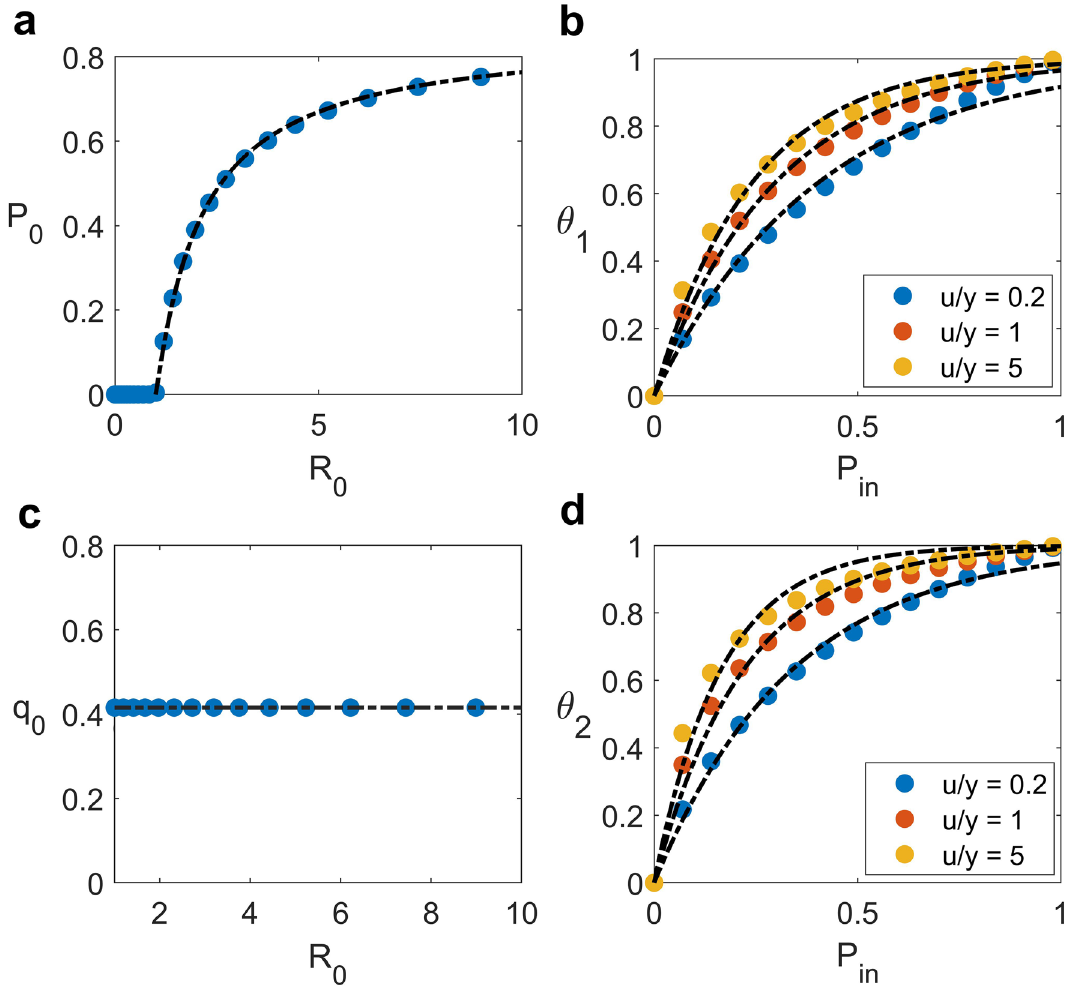
Figure 2. Prevalence and fraction of colonized patients. ( a ) Hospital prevalence and ( c ) fraction of colonized patients as a function of R 0 with zero incoming prevalence, P in = 0 . ( b ) Contribution weight for prevalence and ( d ) the fraction of colonized patients as a function of P in . The disease is assumed to spread with R 0 = 1.5 . Different colours represent different ratios of fractions of symptomatic colonized to asymptomatic colonized patients admitted to the hospital. Black-dash lines are the best fit for simulation data.